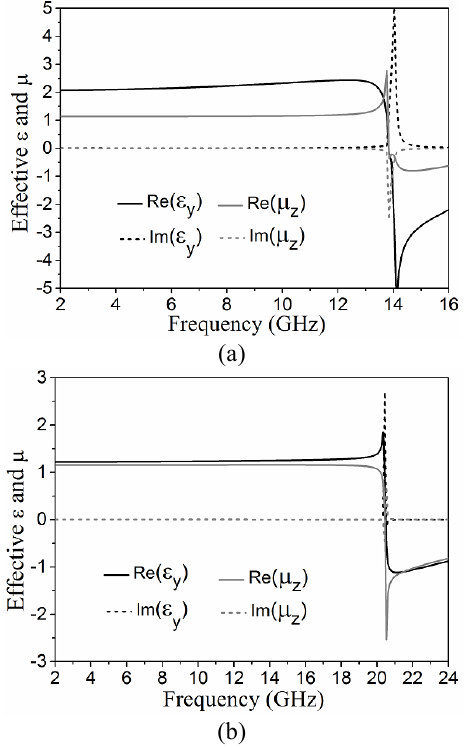
Figure 3: Effective parameters of the unit cell metamaterial, (a) Effective permittivity ( ε mm and (b) Effective permittivity ( ε for m =1.1